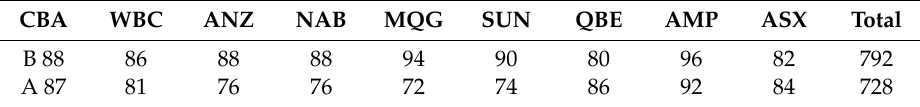
Table 6. Number of Runs before (B) and After (A) Short Selling Ban in Australia.